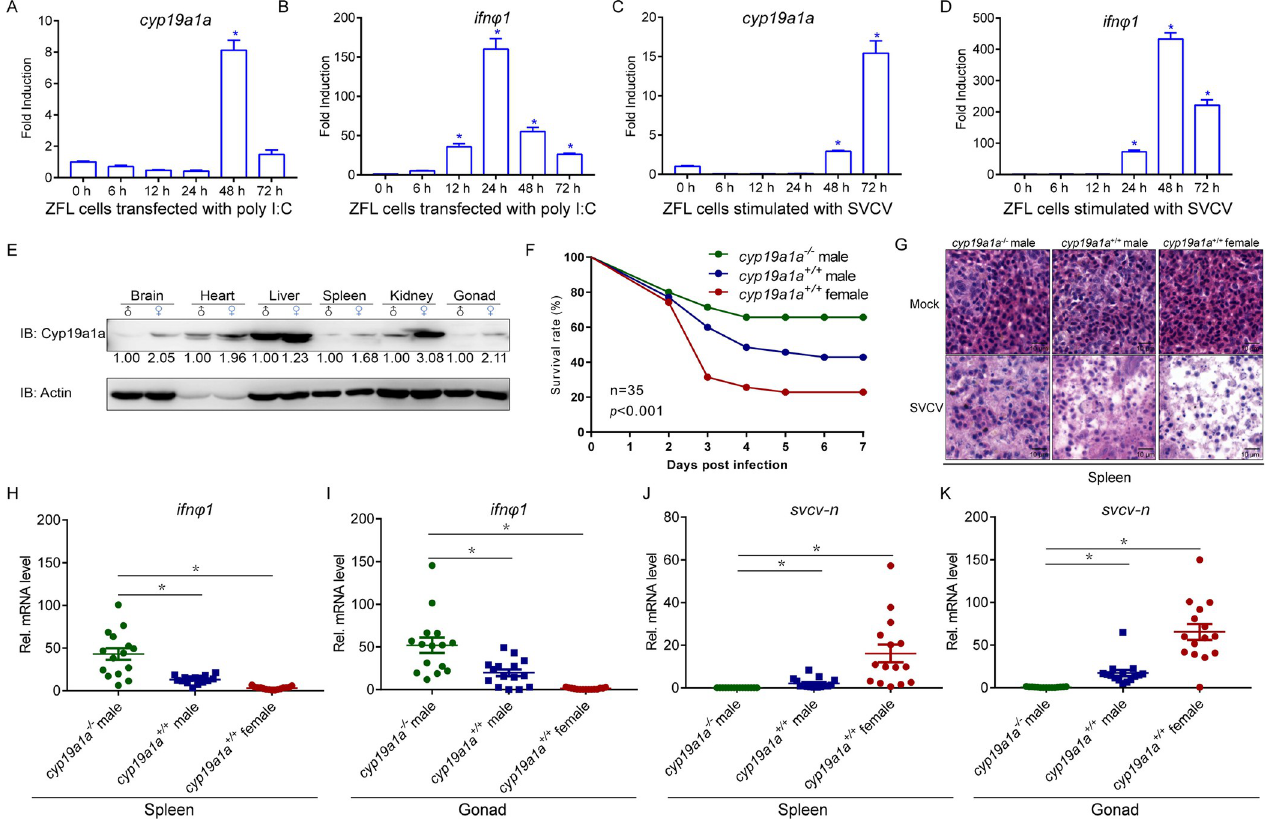
Fig 2. Loss of cyp19a1a protect zebrafish from virus infection. (A-D) Cyp19a1a is induced by virus infection. qPCR detection of the mRNA levels of cyp19a1a and ifnφ1 on stimulation. ZFL cells were seeded in 3-cm 2 dishes overnight and transfected with poly I:C (1 μ g/ml) (A and B) or infected with SVCV (MOI = 1) (C and D). At the time points 6, 12, 24, 48, and 72 h, total RNAs were extracted for further qPCR assays. The relative transcriptional levels were normalized to the transcription of β -actin and represented as fold induction relative to the transcriptional level in control cells, which was set to 1. Data were expressed as mean ± SEM, n = 3. Asterisks indicate significant differences from control ( � , p < 0.05). (E) IB analysis of endogenous Cyp19a1a protein level in the brain, heart, liver, spleen, kidney, and gonad of male and female zebrafish (n = 3 per group). (F) Survival (Kaplan-Meier Curve) of cyp19a1a -/- male, cyp19a1a +/+ male, and cyp19a1a +/+ female zebrafish (n = 35 per group) at various days after i.p. injected with SVCV (5 × 10 8 TCID50/ml, 5 μ l/individual). (G) Microscopy of H&E-stained spleen section from cyp19a1a -/- male, cyp19a1a +/+ male, and cyp19a1a +/+ female zebrafish treated with SVCV (5 × 10 8 TCID 50 /ml, 5 μ l/individual) for 72 h. (H-K) qPCR analysis of ifnφ1 and svcv-n mRNA in the spleen and gonad of cyp19a1a -/- male, cyp19a1a +/+ male, and cyp19a1a +/+ female zebrafish (n = 15 per group) given i.p. injection of SVCV (5 × 10 8 TCID50/ml, 5 μ l/individual) for 48 h. Each dot point represents one independent biological replicate. � p <